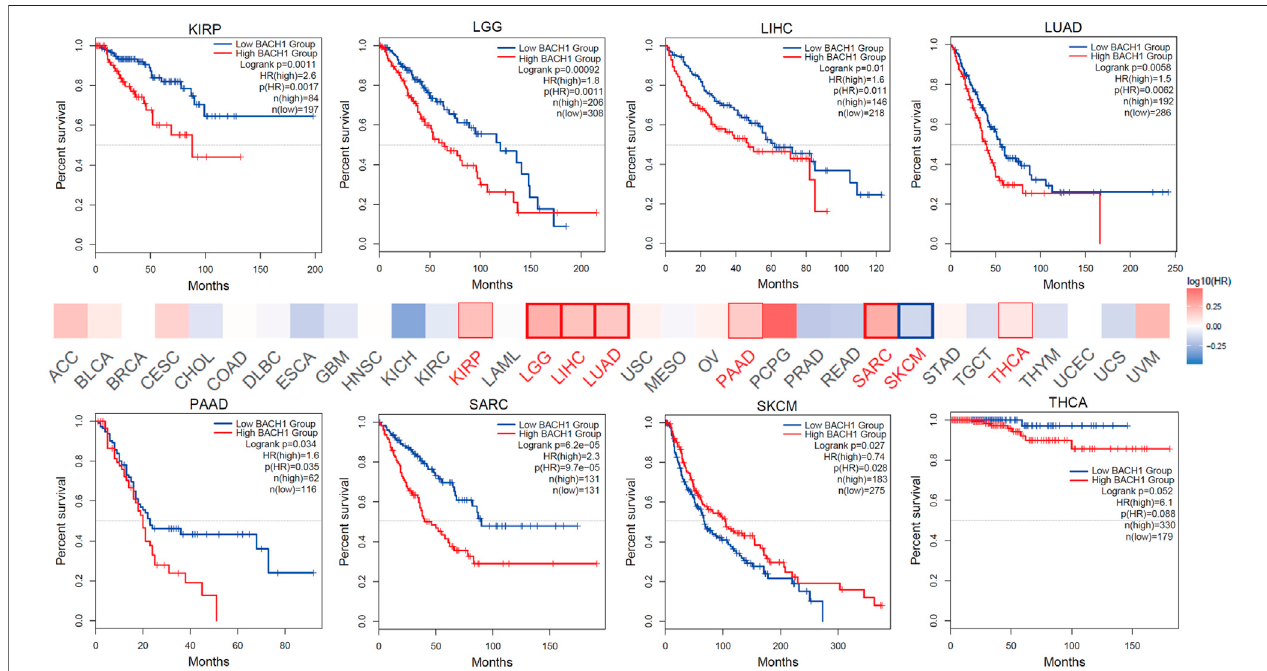
FIGURE 2 | Expression of BACH1 and its association with prognosis in different